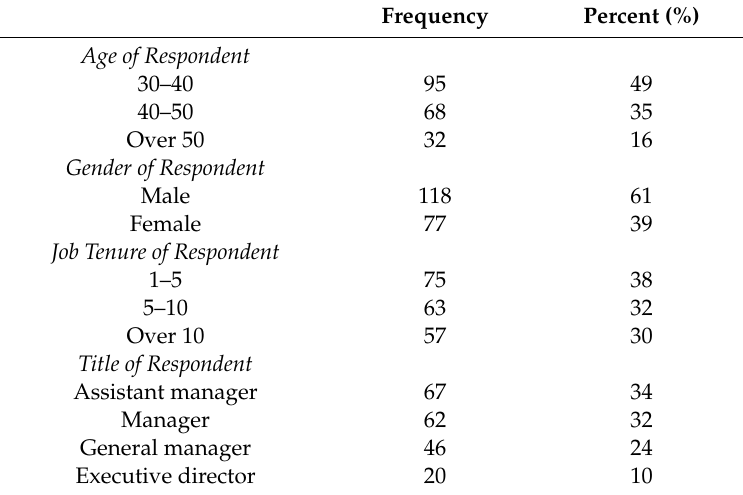
Table 2. Profiles of companies and